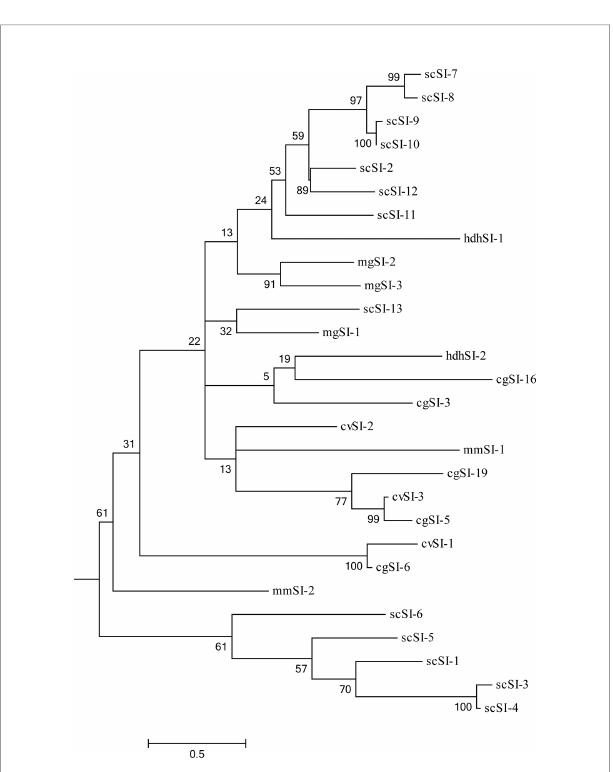
FIGURE 2 | Maximum Likelihood (ML) phylogenetic tree containing 28 members of Family I84 protein sequences without signal peptide.